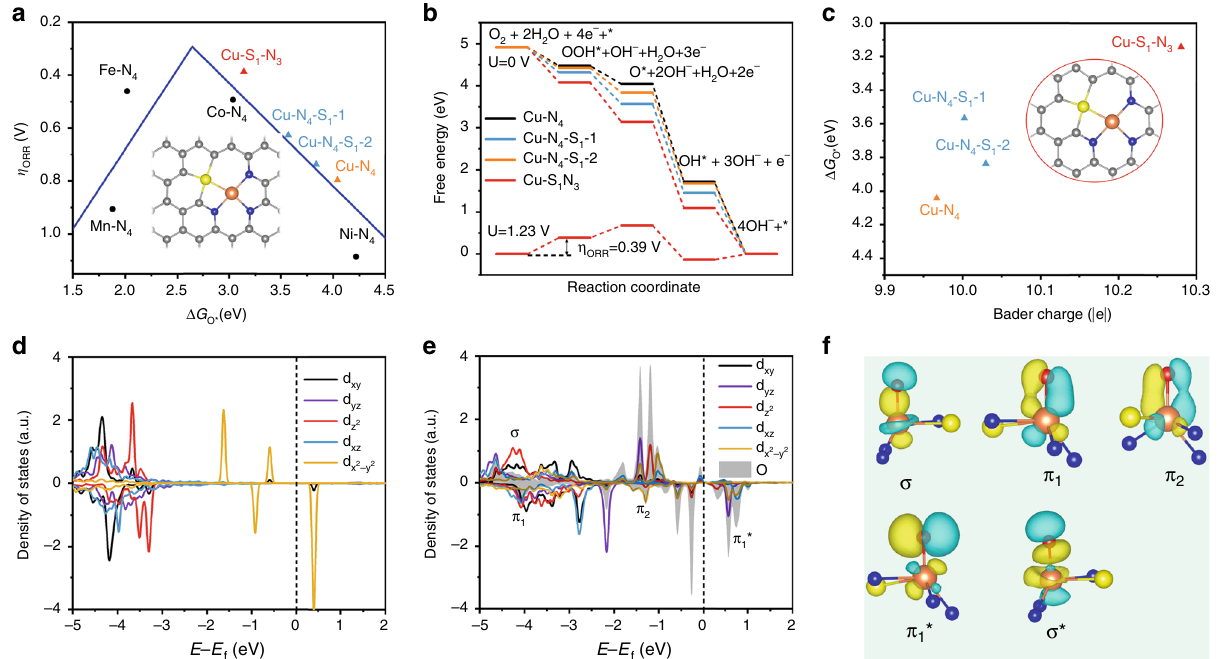
Fig. 5 Theoretical ORR activity of S-Cu-ISA/SNC. a ORR overpotential ( η ORR ) as a function of O* adsorption free energy ( Δ G O* ) on different Cu-centered moieties. Gray, blue, orange and yellow balls represent C, N, Cu and S atoms, respectively. b Free-energy diagram for different Cu-centered moieties. c Relationship between the number of Bader charge of Cu and Δ G O* for different Cu-centered moieties. Projected density of states of Cu and O* d before and e after O* adsorption for Cu-S 1 N 3 in S-Cu-ISA/SNC. f Molecular orbitals of O* adsorbed on Cu-S 1 N 3 in S-Cu-ISA/SNC. σ and σ * represent the bonding and antibonding between d z 2 orbital of Cu and p orbital of O, π 1 and π 1 * represent the bonding and antibonding between d yz / d xz orbital of Cu and p orbital of O, π 2 represents the bonding between d x 2 (cid:1) y 2 orbital of Cu and p orbital of O.